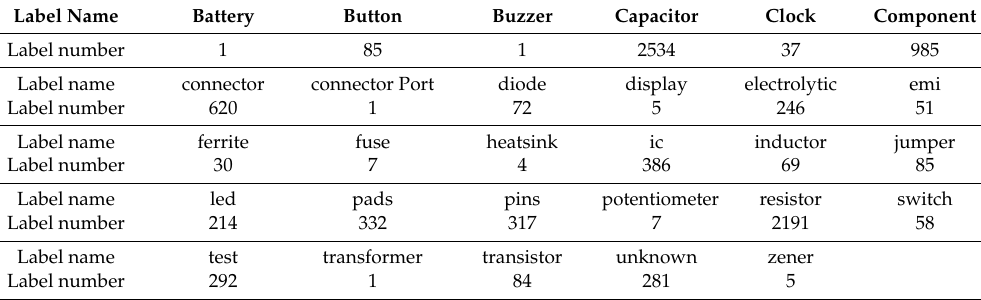
Table 1. Statistical analysis table of pre-processing label